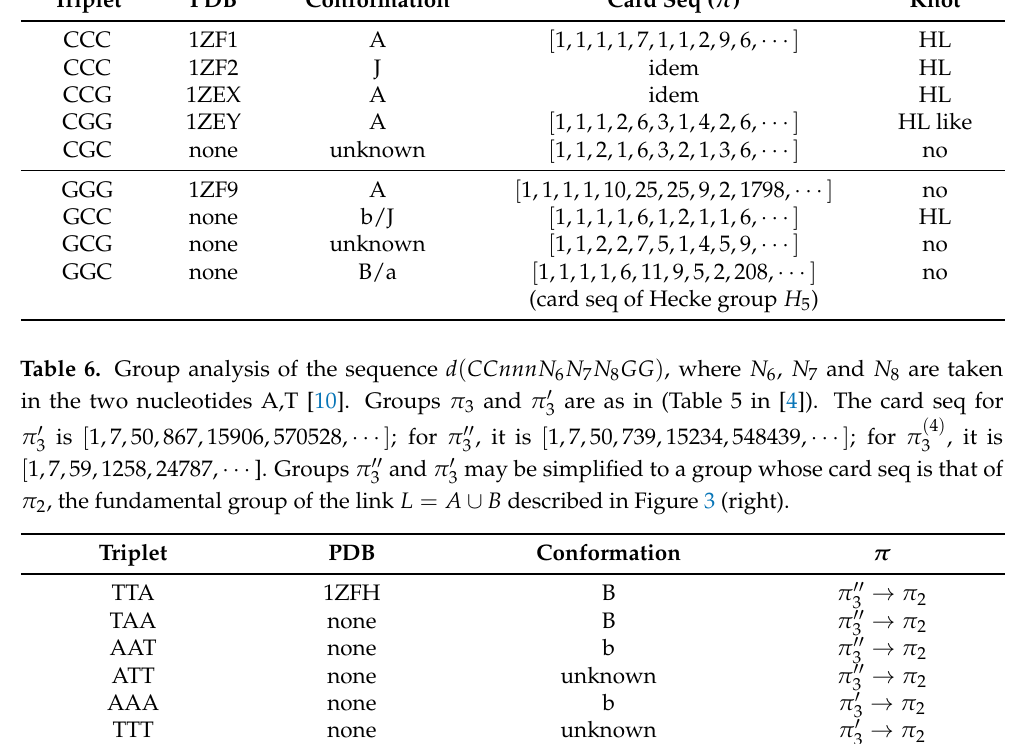
Table 5. Group analysis of the sequence d ( CCnnnN 6 N 7 N 8 GG ) , where N 6 , N 7 and N 8 are taken in the two nucleotides G and C and nnn is specified in order to maintain the self-complementarity of the sequence [10]. The first column is for the selected triplet N 6 N 7 N 8 , the second column is for the code in the protein data bank, the third column is for the DNA conformation when known (see Table 1 in [10]), the fourth column is for the cardinality structure of subgroups of π and the fifth column checks the occurrence of a surface corresponding to the Hopf link in the factorization of the SL ( 2, C ) of π . The symbols A, B and J are for A-DNA, B-DNA and a four-stranded Holliday junction; lowercase is used when the conformation is not confirmed in [10].